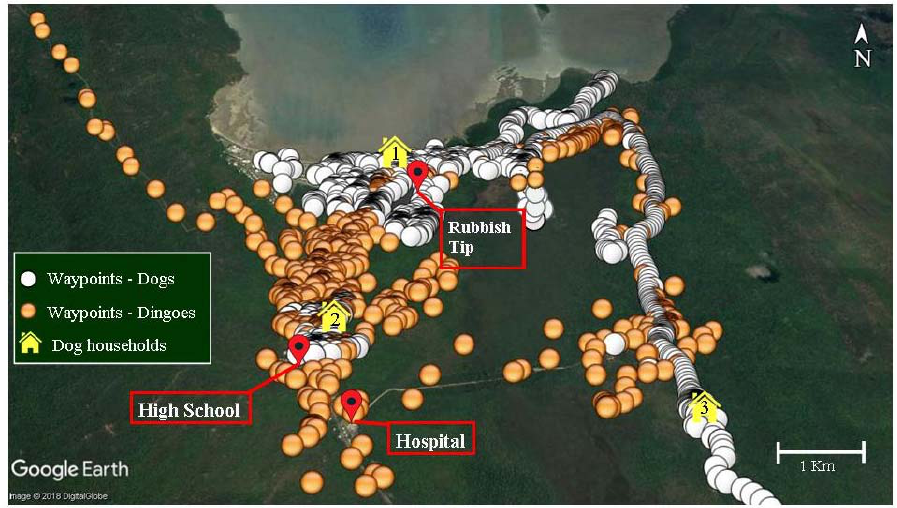
Figure 3. Waypoints for all tracked dingoes and dogs, plus key locations in and around Yarrabah.